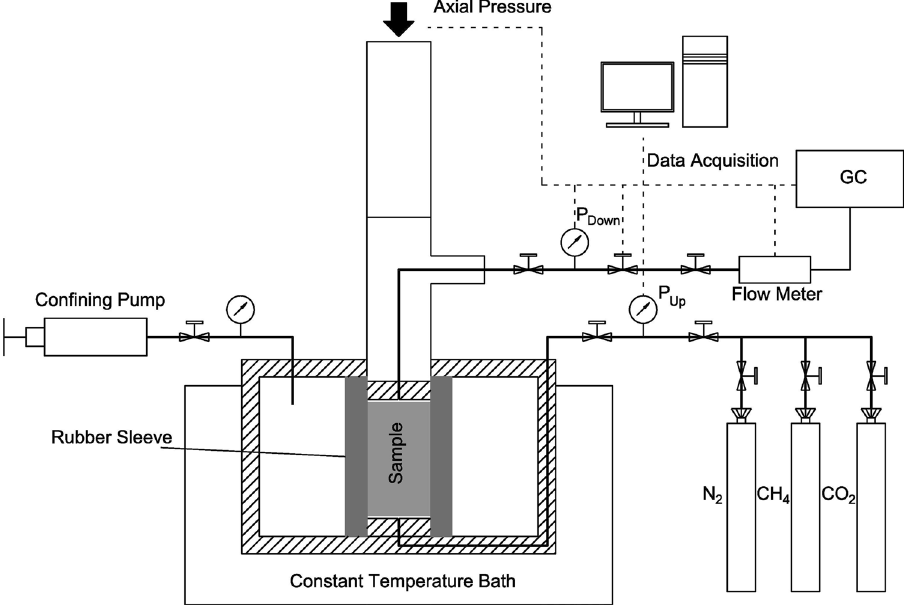
Fig. 5 Conventional triaxial equipment (Zhang et al. 2016a, b, c,